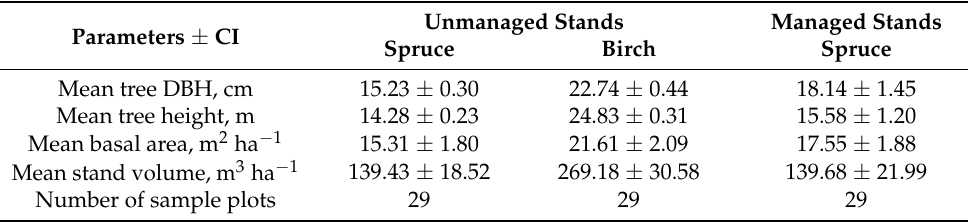
Table 2. Characteristics of mixed (unmanaged) and monospecific (managed) stands, where for unmanaged stands prevailing tree species are Betula pendula Roth. and Picea abies (L.) Karst.,